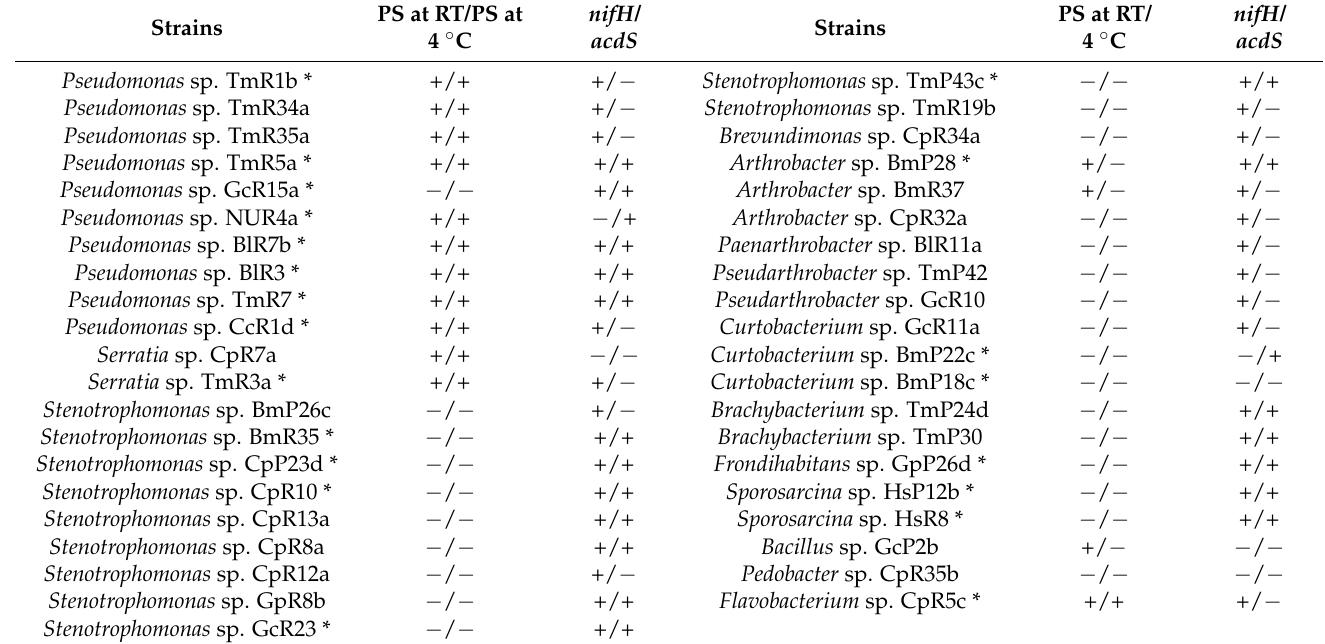
Table 3. Selected strains showing the higher phosphate solubilization activity and presence of nifH and acdS genes revealed by